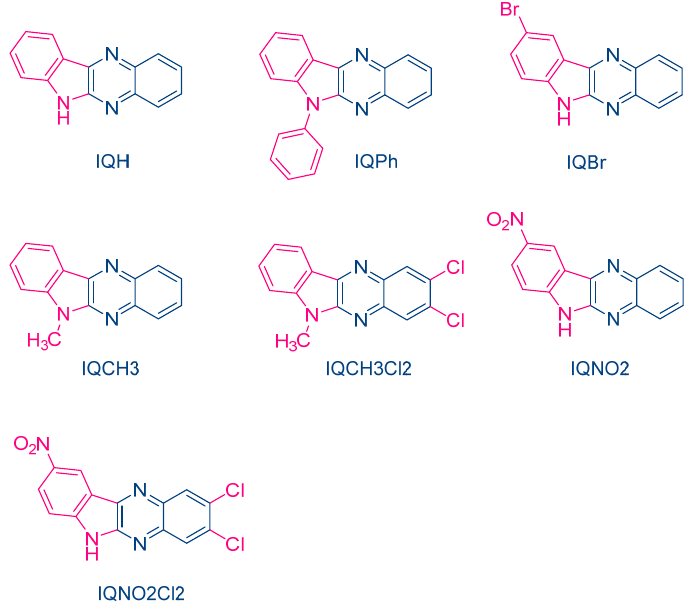
Figure 7. Chemical structures of different 6 H -indolo[2,3- b ]quinoxalines. Table 2. Absorption maxima of different quinoxaline dyes in ethyl acetate.